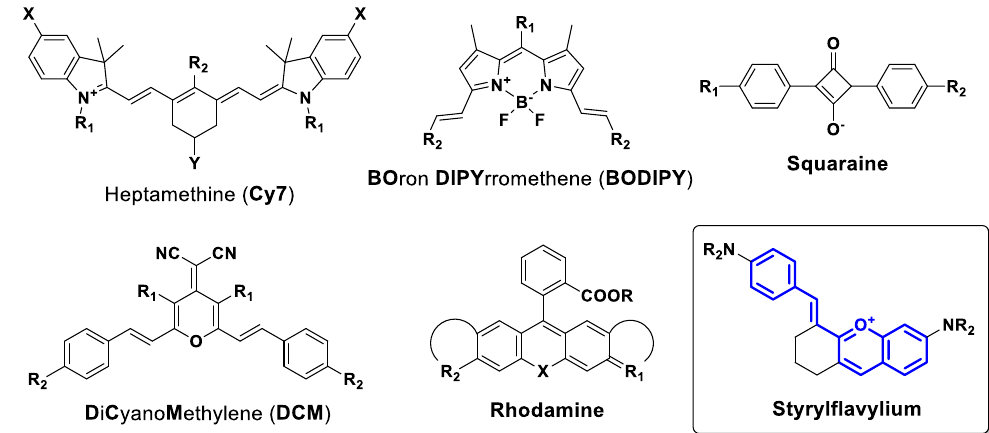
Figure 1. Examples of NIR fluorophores. The styrylflavylium core is highlighted in